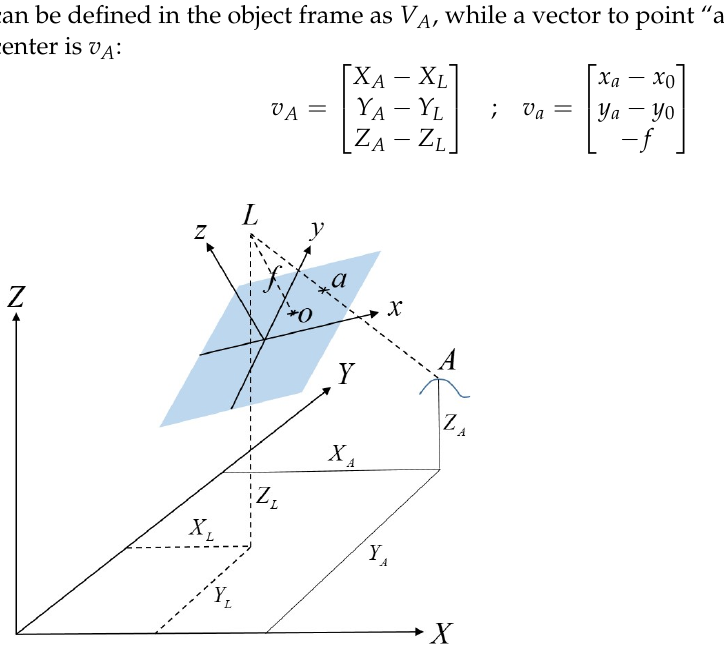
can be defined in the object frame as V A , while a vector to point “a” from the perspective center is v A :